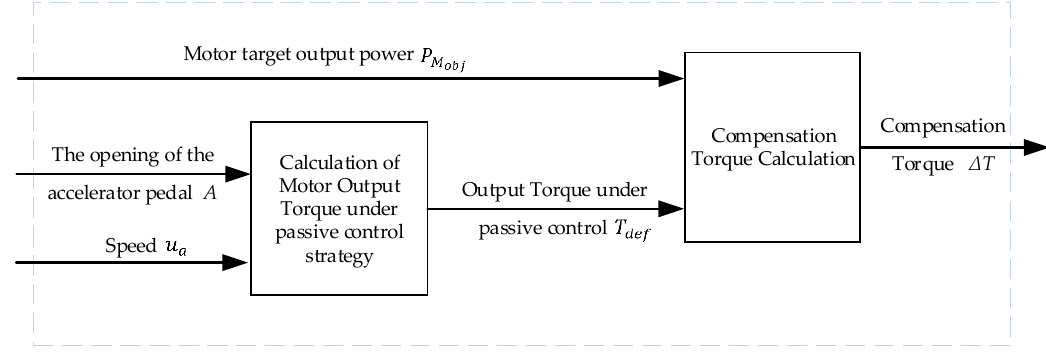
Figure 10. The torque compensation algorithm.